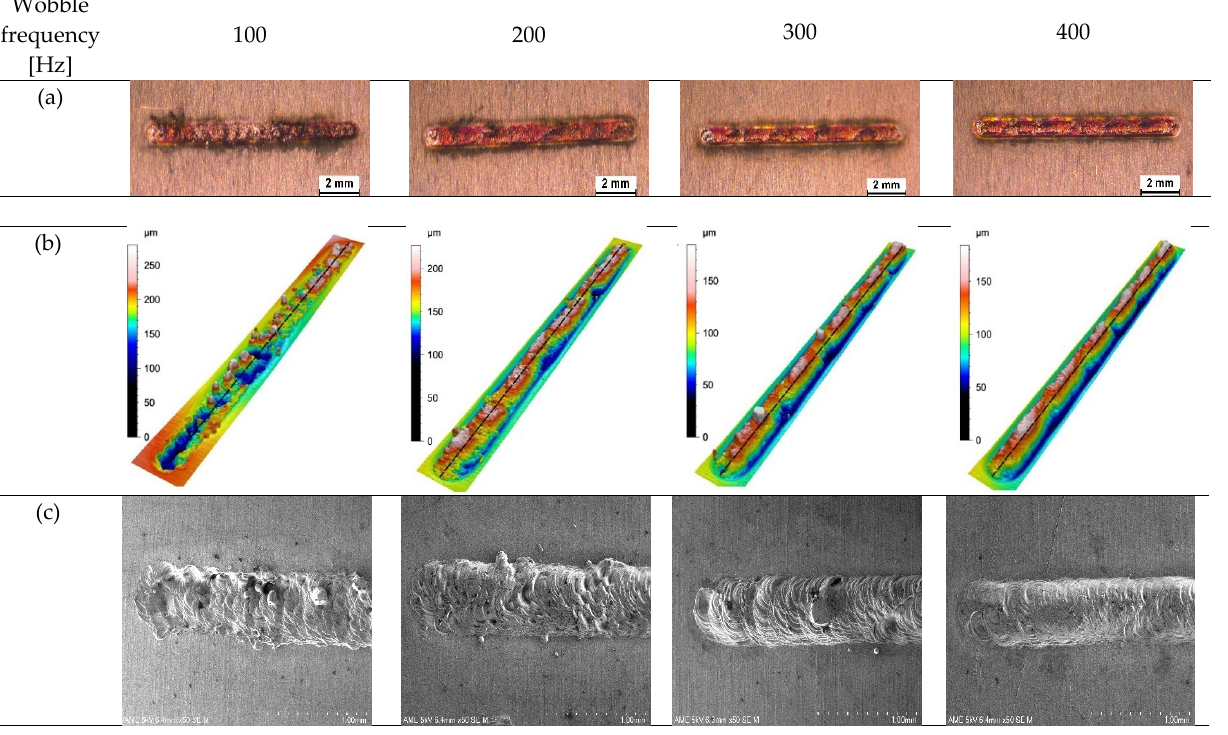
L/min). L/min). (P = 750 W, PRR = 20 Hz, PW = 10 ms, A = 0.4 mm, V w = 2 mm/s, and gas flow = 15 L/min).